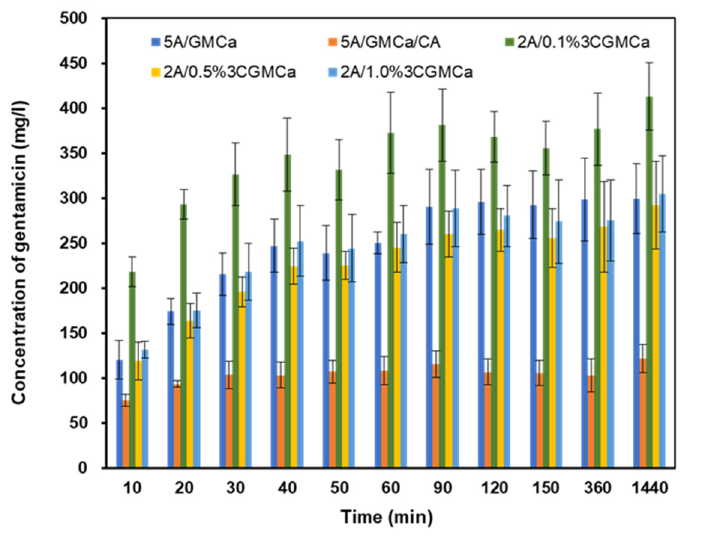
Figure 10. The total amount of gentamicin released from GM-loaded alginate-chitosan (2A/x%3CGMCa, x = 0.1, 0.5, 1.0) beads and GM-loaded alginate beads without/with citric acid (5A/GMCa, 5A/GMCa/CA) as a function of immersion time in PBS solution. Error bars represent the standard deviation from three samples per sample group.